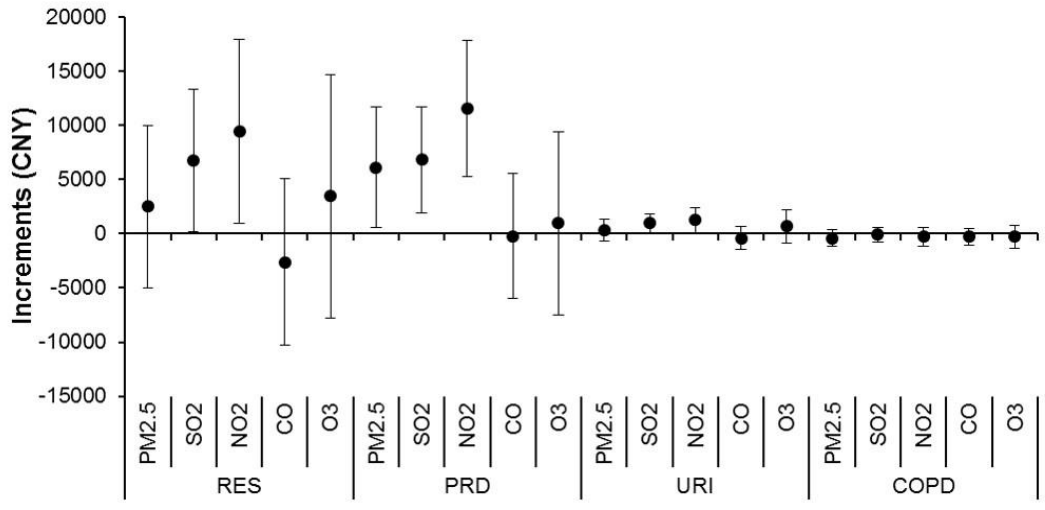
Figure 4. Cumulative increments of daily medical expenditure due to outpatient visits for respiratory diseases associated with an interquartile range increase in air pollutant concentrations over a lag of zero to three days. Abbreviations as shown in Tables 1 and 2.